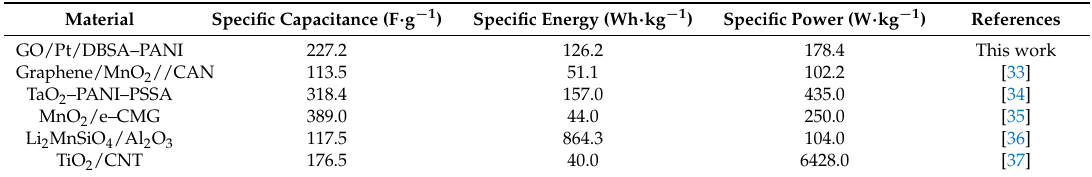
Table 1. Comparison table of specific capacitances, energy and power of different supercapacitor electrode materials over the